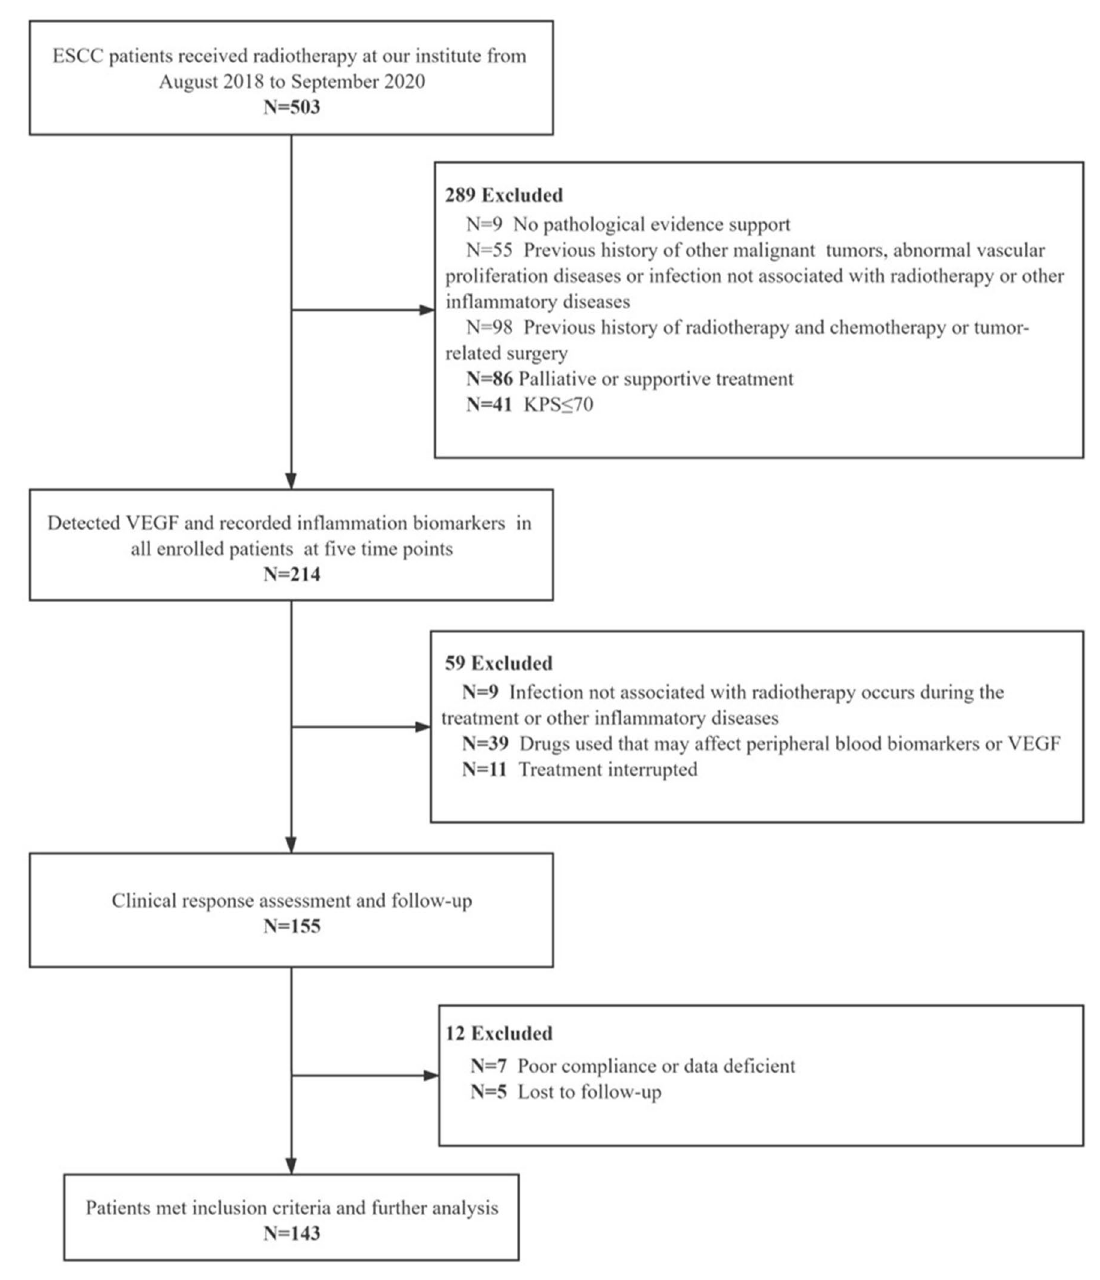
Figure 1. Patient enrollment flow